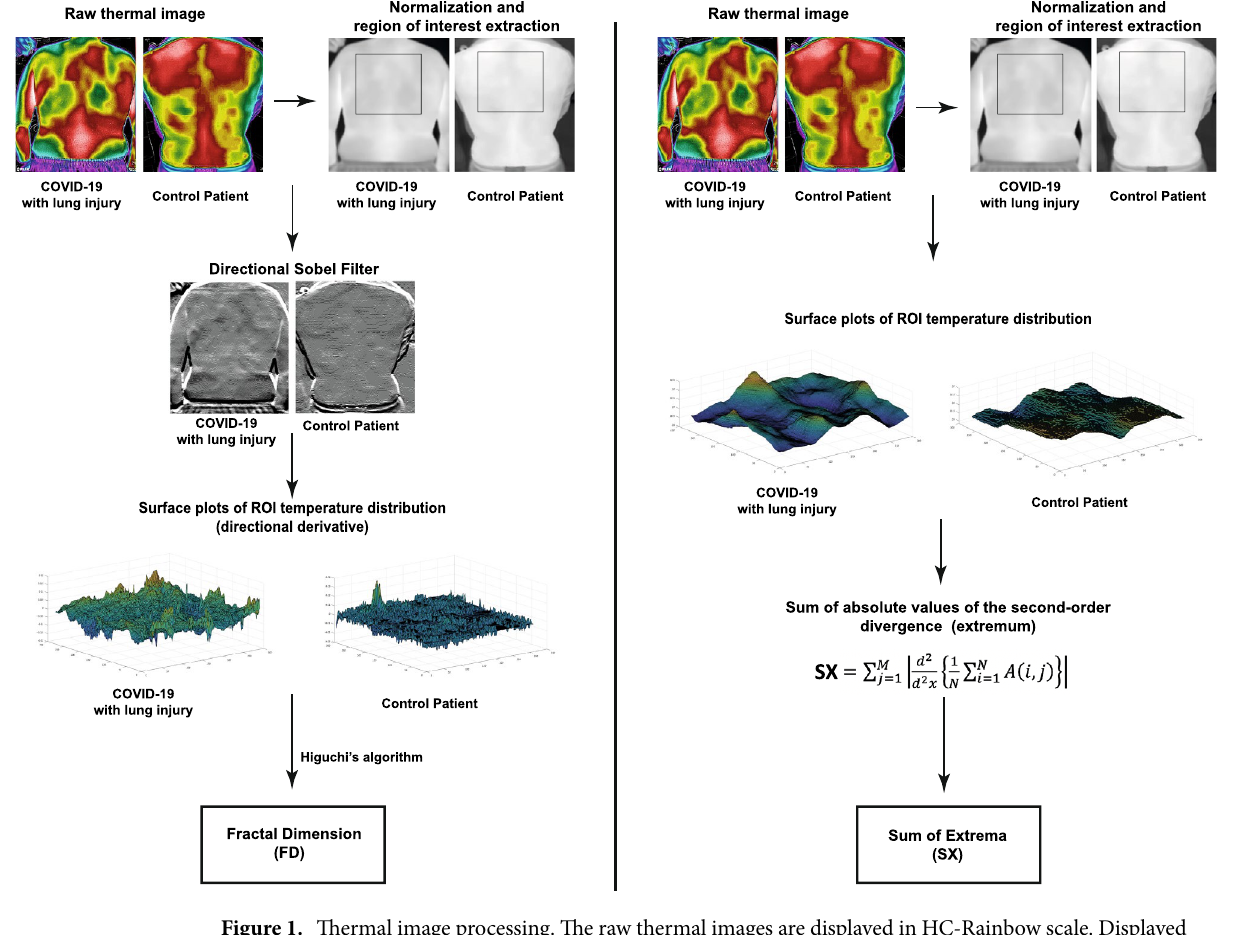
Figure 1. Thermal image processing. The raw thermal images are displayed in HC-Rainbow scale. Displayed are representative images of the different stages of our image processing algorithms for the fractal dimension (FD) of the gradient (left) and the “sum of extrema” (SX) in the image (right). For this display the gradient range [-8, 8] was normalized to [0, 255]. All gradient values outside of this range were shifted to its edges before normalization. Full details on image processing algorithms are provided in the Methods section. ROI region of interest.